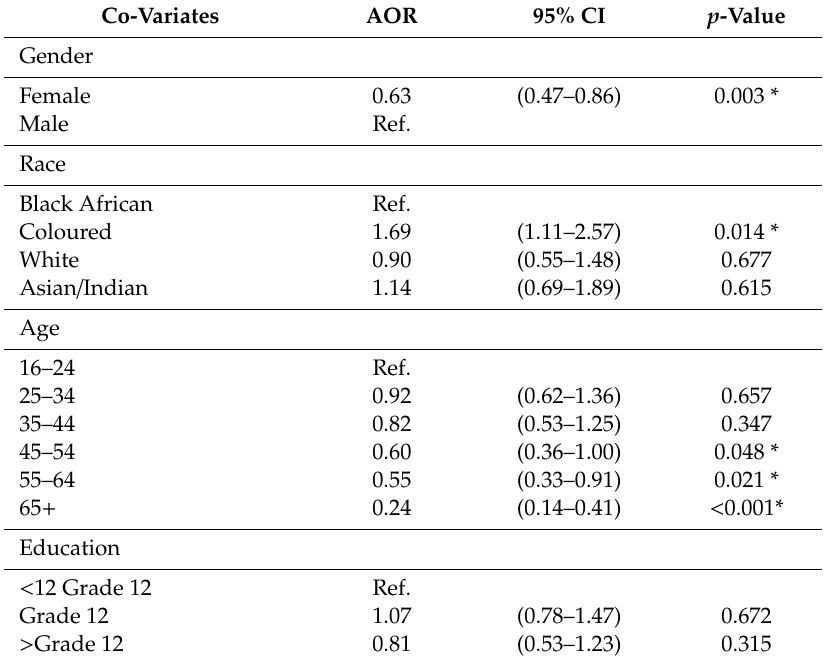
Table 4. Multiple-variable-adjusted logistic regression for any level of exposure to